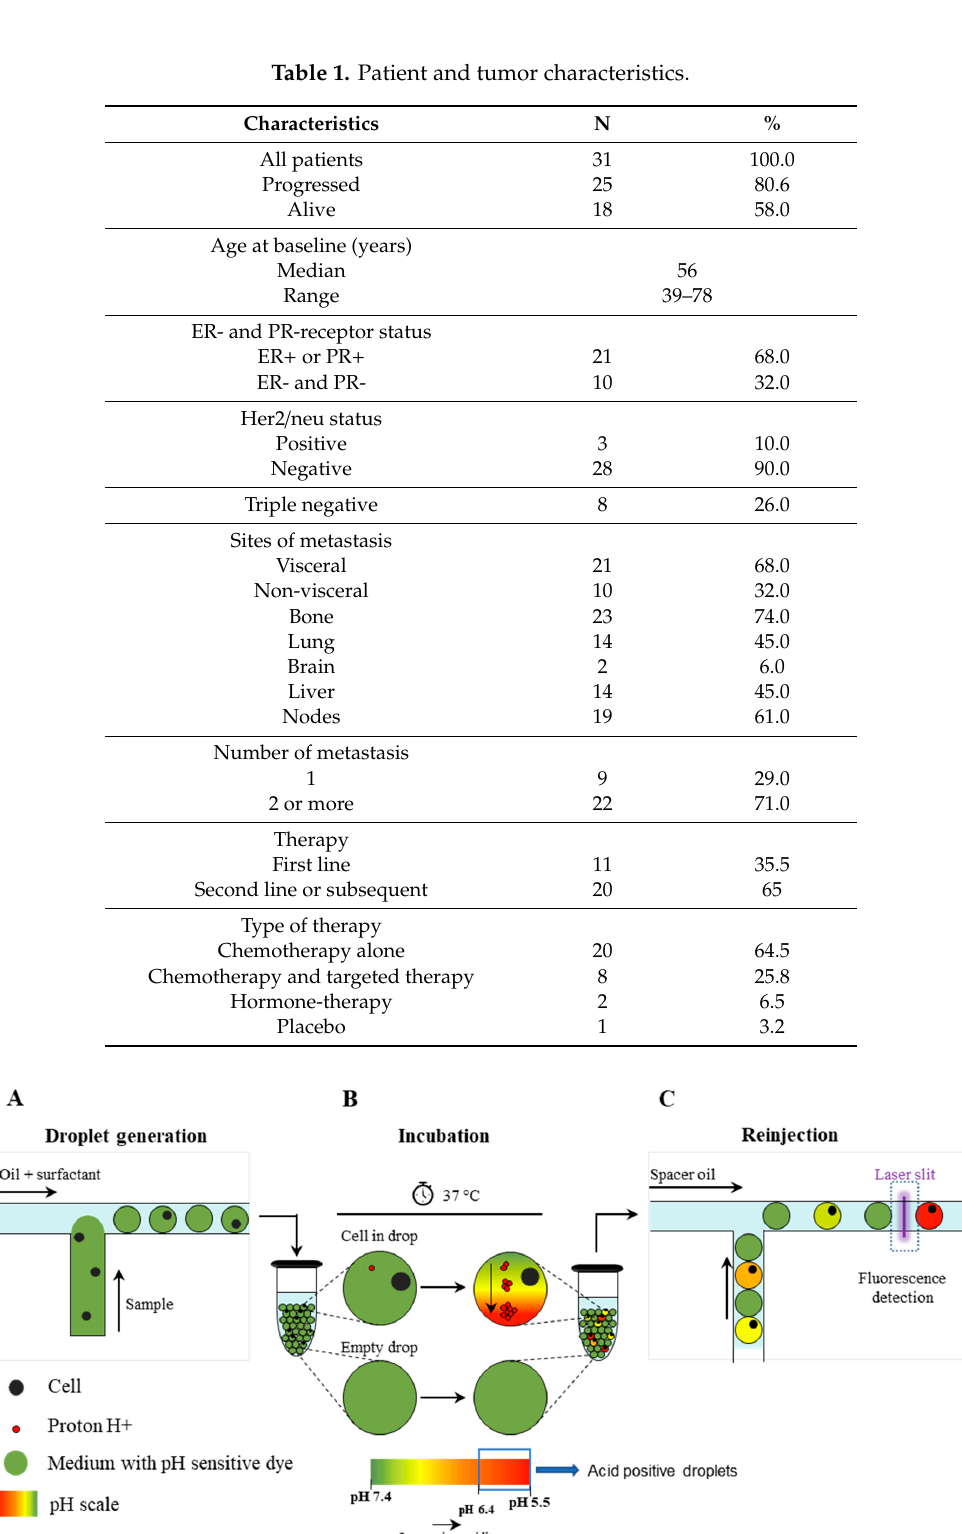
Figure 1. Schematic overview of the droplet microfluidic single-cell MBA for determination of the extracellular pH. ( A ) Single-cells are encapsulated into picoliter droplets together with an extracellular pH-sensitive dye (SNARF-5F); ( B ) During in-drop incubation, single cells secrete a certain quantity of protons (H+) which leads to a decrease of the pH value (i.e., acidification of the droplet content); ( C ) Droplets are reinjected into a second microfluidic device and screened for fluorescence by the optical setup.